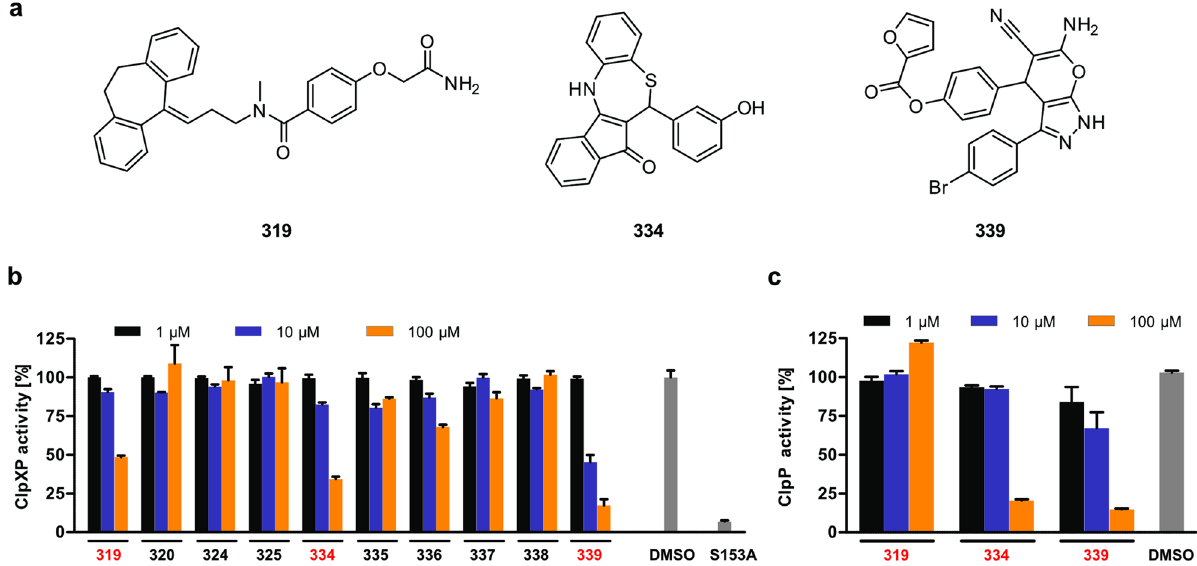
Figure 1. Small molecule 334 is a promising candidate for inhibition of the ClpXP complex. ( a ) The chemical structures of the small molecules 319, 334 and 339 inhibiting the ClpXP complex. For the chemical structure of all molecules tested for inhibition see also Supplementary Fig. S1 online. ( b ) Small molecules with activity towards the bacterial SaClpXP complex were tested for their inhibitory potential against the HsClpXP isoform. The ClpXP enzyme activity was assessed by fluorescence recording of cleaved FITC-casein conjugates (n = 3). ( c ) Promising candidates 319, 334 and 339 were additionally tested for inhibition of the HsClpP peptidase activity. Enzymatic activity of HsClpP was measured by monitoring the cleavage of the fluorogenic substrate Ac-Ala- hArg-2-Aoc-ACC (n =